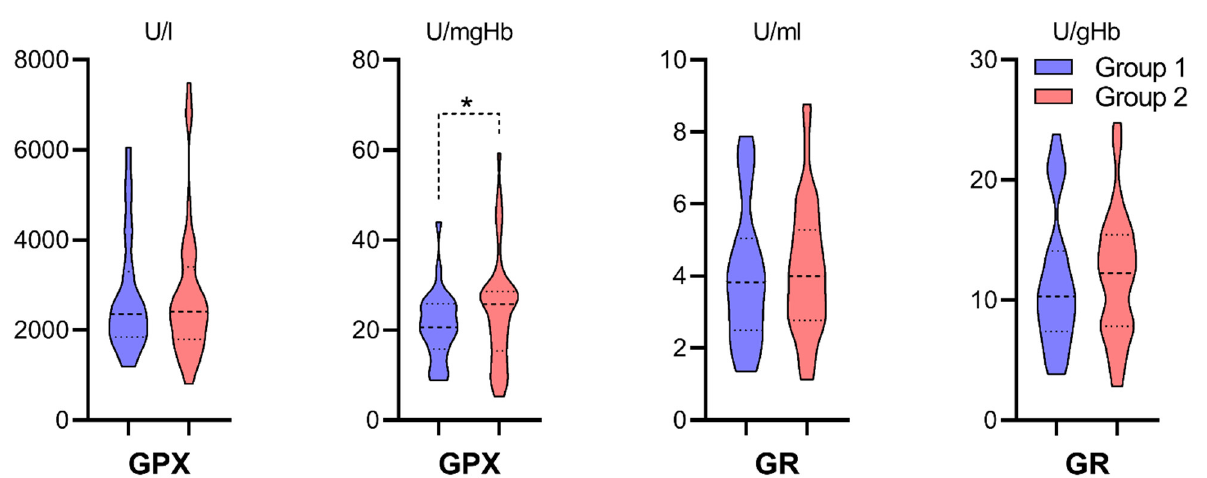
Figure 6. Violin plots of distribution ( N = 66, n 1 = 26, n 2 = 40): GPX activity per volume (Mann-Whitney U test, p = 0.9429), GPX activity per hemoglobin mass (Kolmogorov–Smirnov two-sample test, * p < 0.05 ), GR activity per volume (Mann- Whitney U test , p = 0.5950), GR activity per hemoglobin mass (Mann-Whitney U test, p = 0.9969).